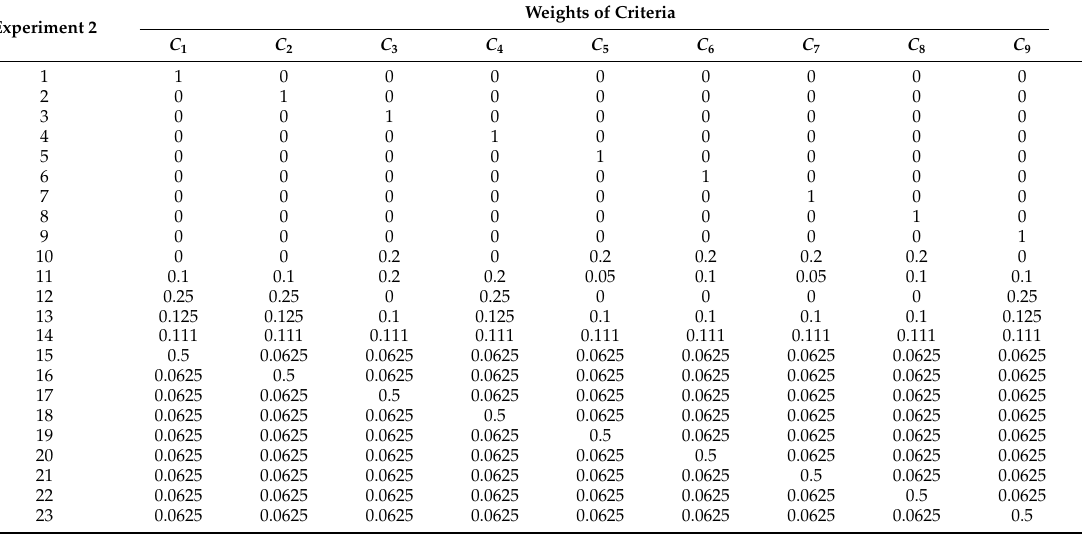
Table 11. Different weight for nine criteria